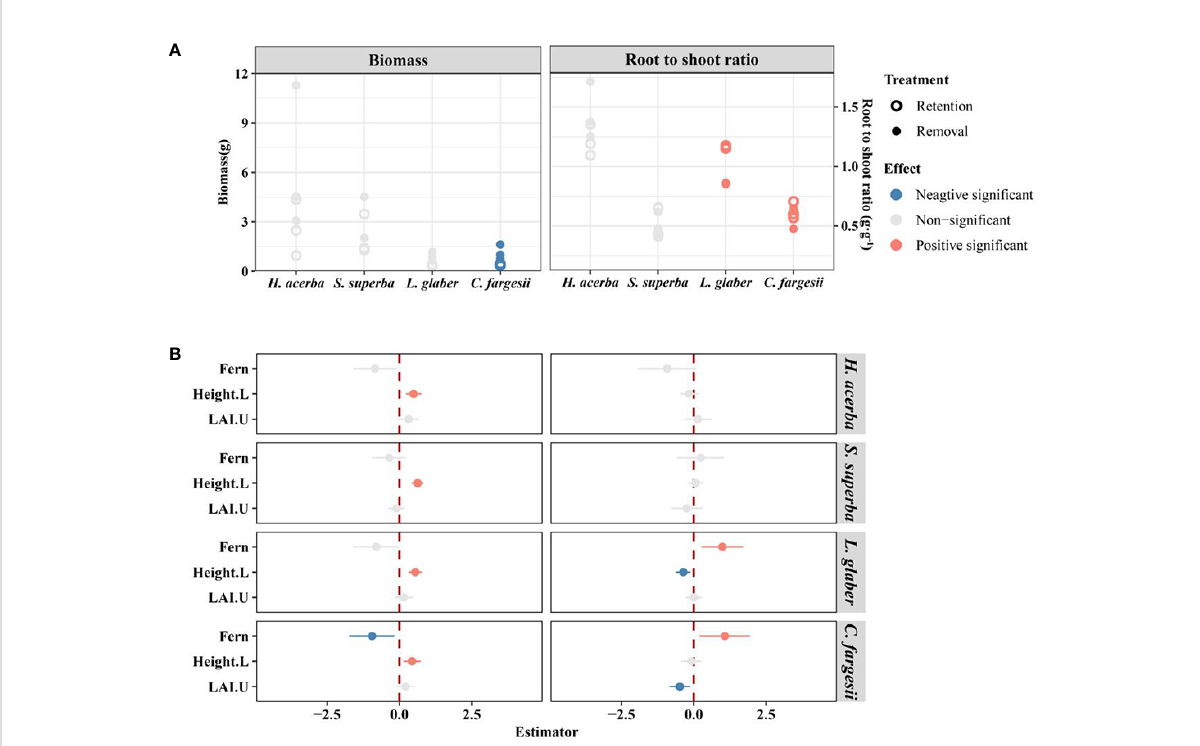
FIGURE 4 The difference in biomass and root/shoot ratio of living seedlings between retention and removal treatments in establishment and development stages (A) , and the corresponding estimator of explanatory variables in linear mixed-effects models (B) . Fern in B refers to the effect of retention treatment vs removal treatment; Height.L refers to the log-transformed height of seedling in the last census; LAI.U is the leaf area index of the plot in the understory. The error bars in B represent 1.96*se around estimator in linear mixed models. Blue and red points in B indicate parameter estimates signi fi cantly different from zero at the alpha = 0.05